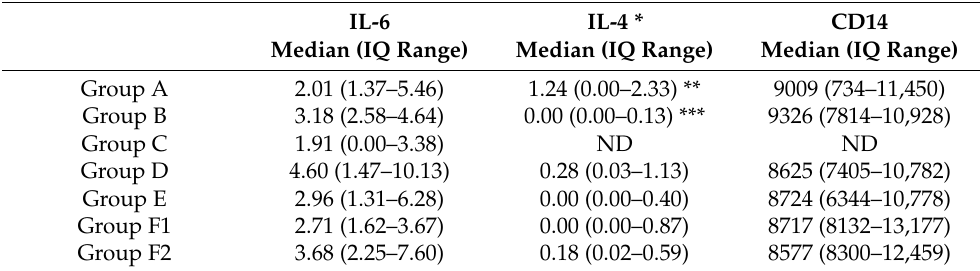
Table 5. Association of cytokines with patient